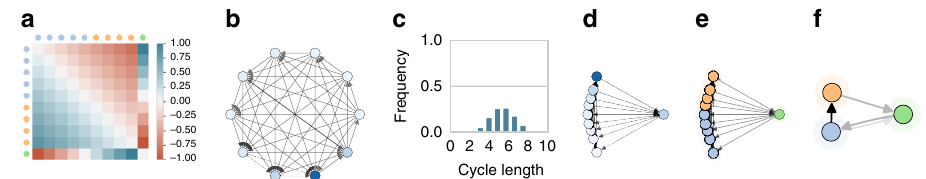
Fig. 4 Cyclical game results. a Game payoffs, b response graph, c cycles histogram, d spectral response graph, e clustered response graph, f contracted response graph.